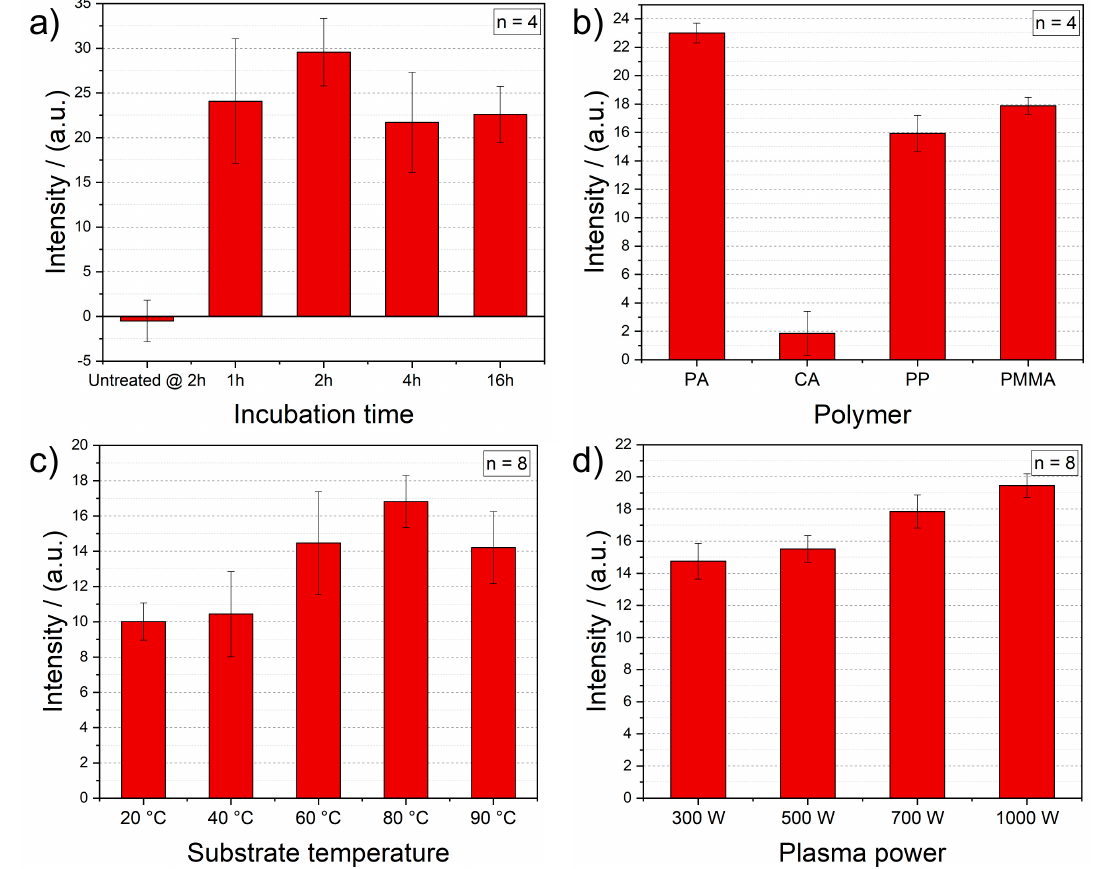
Figure 2. ( a ) Optimization of incubation time of the gold NP labelled antibodies on the plasma activated PMMA surface (100% O 2 , 3 min, 1000 W, 80 °C) and the background signals of 2-h incubation of antibodies on untreated PMMA foils for comparison. ( b ) Optical intensity measurement of antibody adsorption on different polymer foils after the plasma treatment (100% O 2 , 3 min, 1000 W, 80 °C). Impact of ( c ) different substrate temperatures of the plasma process (100% O 2 , 3 min, 1000 W), and ( d ) different power values of the plasma process (100% O 2 , 3 min, 80 °C) on the antibody immobilization on PMMA foils.